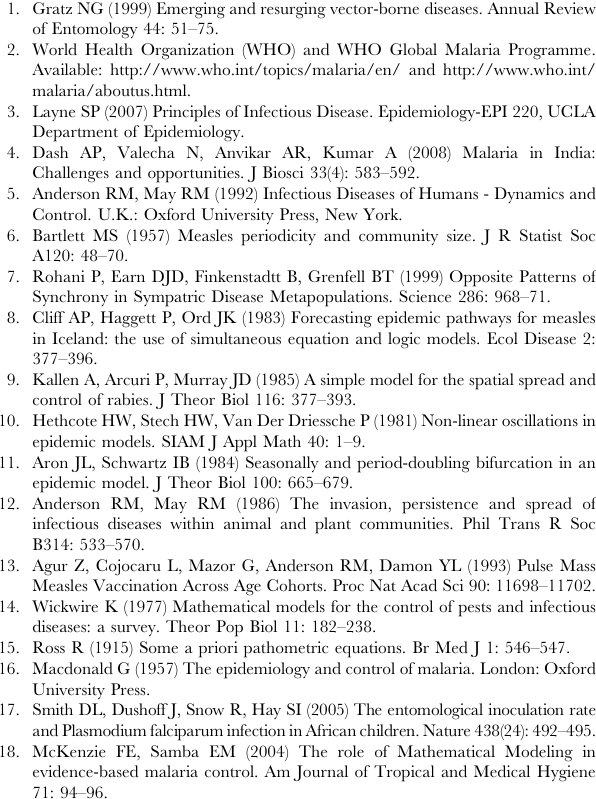
Figure S2 Population data for Chennai and fitted population series (Solid lines with squares-observed series; dashed line-fitted polynomial). Found at: doi:10.1371/journal.pone.0004726.s003 (3.63 MB TIF) Figure S3 Correlogram of SPR values. Figure S4 Scatter plots between the selected variables and the dependent variables showing the initial functional relationship: (a) log (SPR) vs. log (Max. Temp) - 4th order polynomial; (b) log (SPR) vs. SPR-at-lag-one - 5th order polynomial; (c) log (SPR) vs. Min. Humidity - 3rd order polynomial; (d) log (SPR) vs. Population - 4th order polynomial. These functional forms represent the optimum relationships (highest R 2 values). Figure S5 Scatter plot between the SPR and number of blood smears collected.